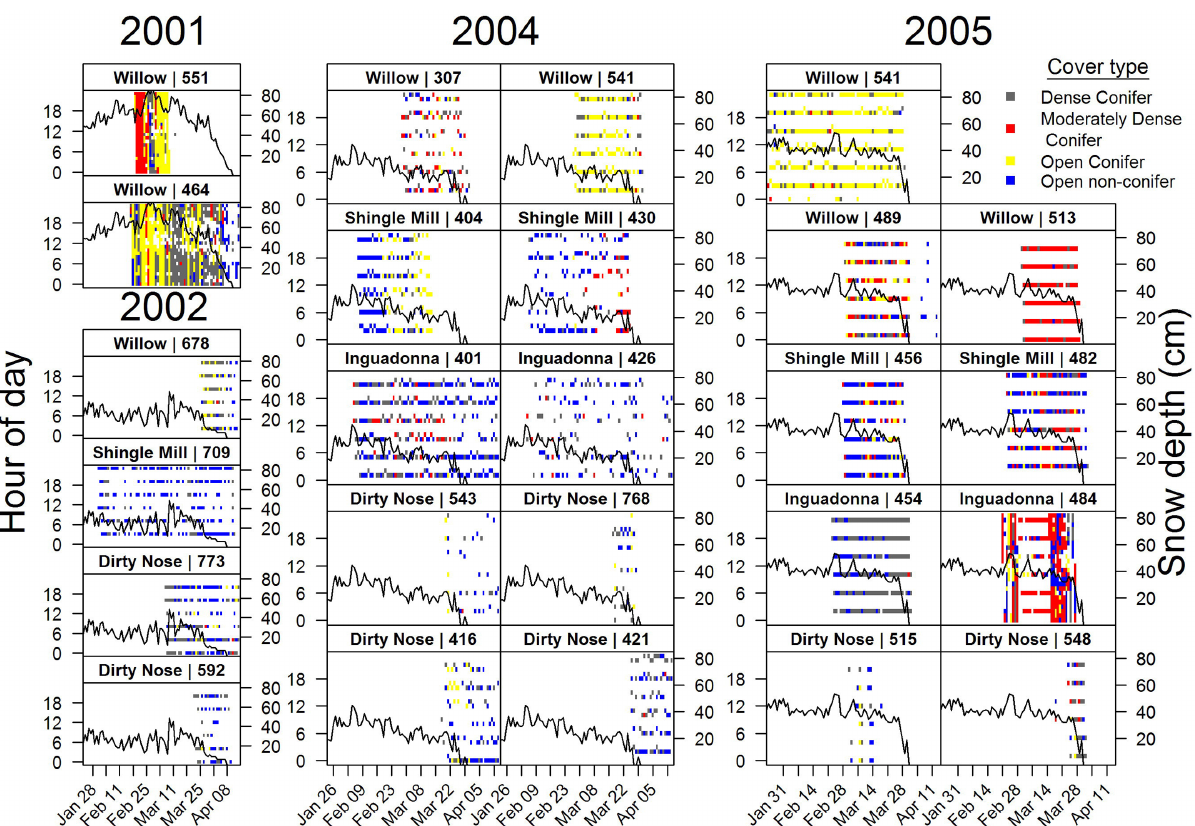
Fig 3. Date-time plots illustrating individual variability in use of dense ( (cid:21) 70%canopy closure), moderately dense (40% (cid:20) ×< 70% canopy closure), and open conifer cover ( < 40% canopy closure), and open non-conifer types (openings and hardwood types) by adult ( (cid:21) 1.5 years old), female white-tailed deer monitored using Global Positioning System (GPS) collars collecting locations hourly or every four hours on four study sites, north-central Minnesota, 23 January–14 April 2001, 2002, 2004, and 2005. The solid black line represents averageweeklysnow